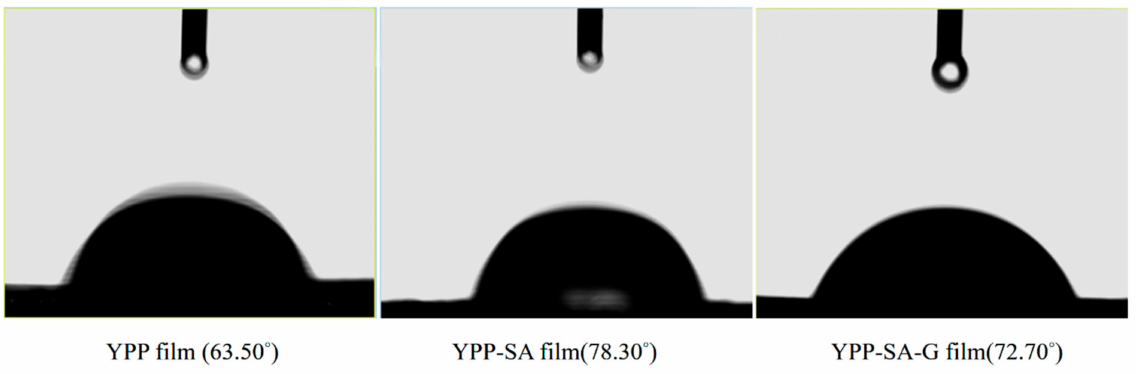
Figure 7. WCA of various films (YPP, YPP-SA,